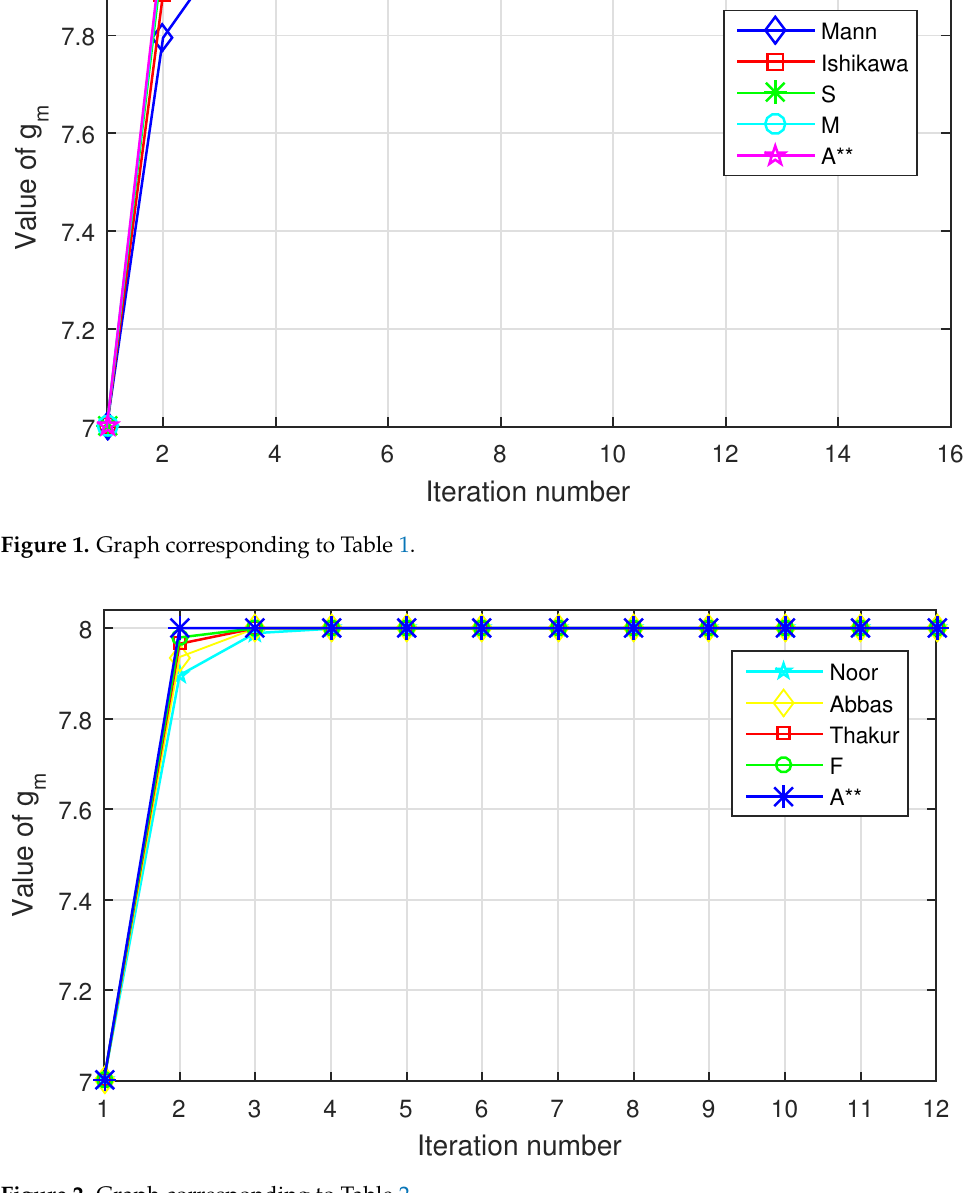
Figure 2. Graph corresponding to Table